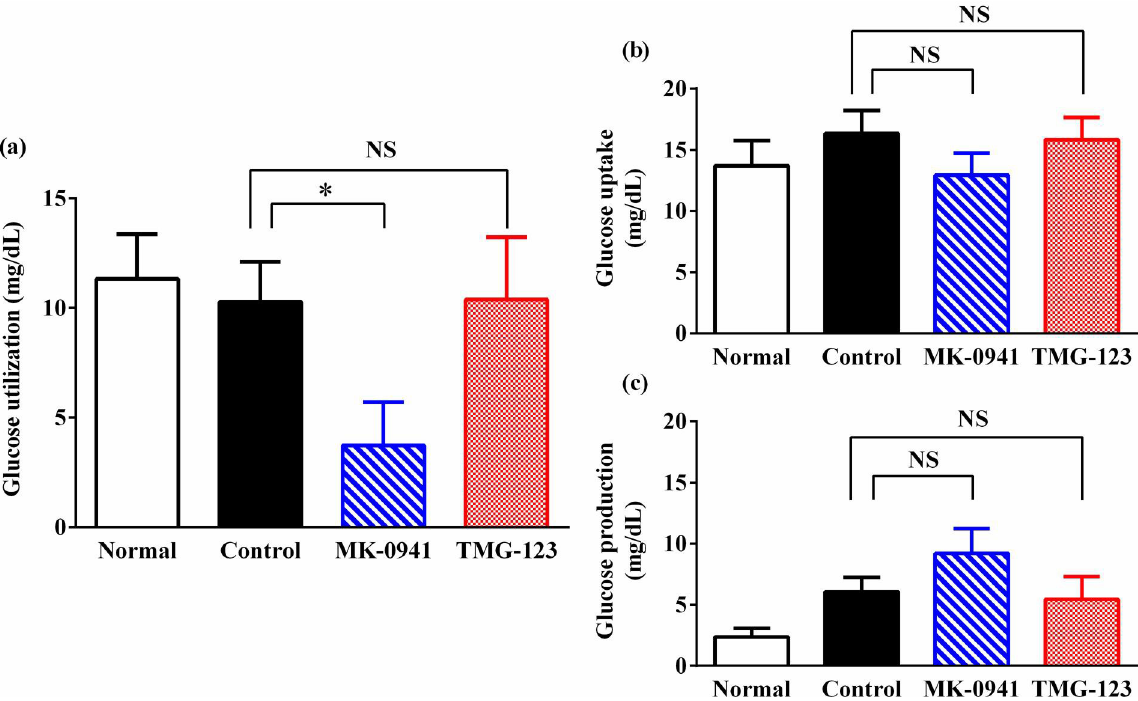
Fig 4. Glucose utilization, uptake, and production after 20-week treatment with GK activators. (a) Glucose utilization, (b) glucose uptake, and (c) glucose production was evaluated with the liver perfusion study at week 20 in the chronic treatment. Normal; Wistar rats, Control; Goto- Kakizaki rats fed normal diet, n = 5–7. � p < 0.05, NS = not